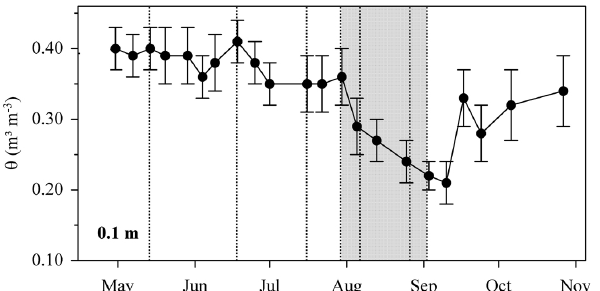
Figure 3. Average volumetric soil water content (FDR sensor) at 0.1m soil depth during the study period in 2009. Values are means ± sd ( n = 16 clusters). Dotted lines indicate the occasions where θ was measured on all 100 clusters with TDRs; the shaded area represents the dry spell (three subsequent measurement inter- vals) for which Wu 30d and Wu 70d were